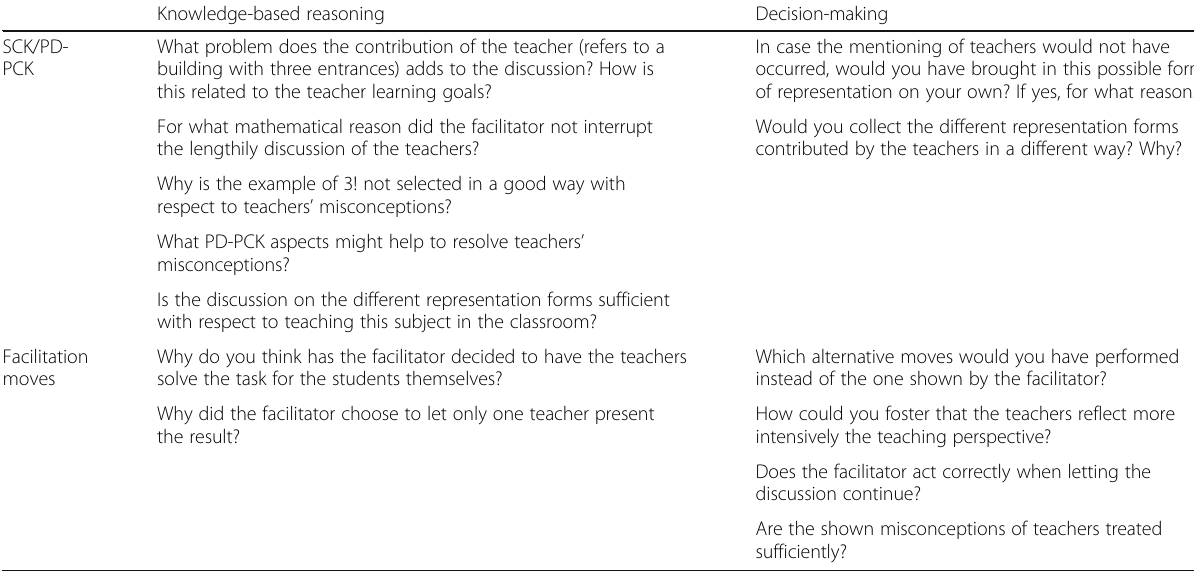
Table 9 Suggested noticing prompts regarding knowledge-based reasoning and decision-making for the categories SCK/PD-PCK and facilitation